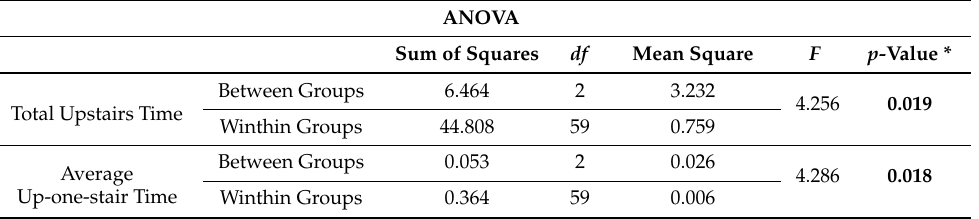
Table 3. ANOVA test of upstairs walking for three groups.